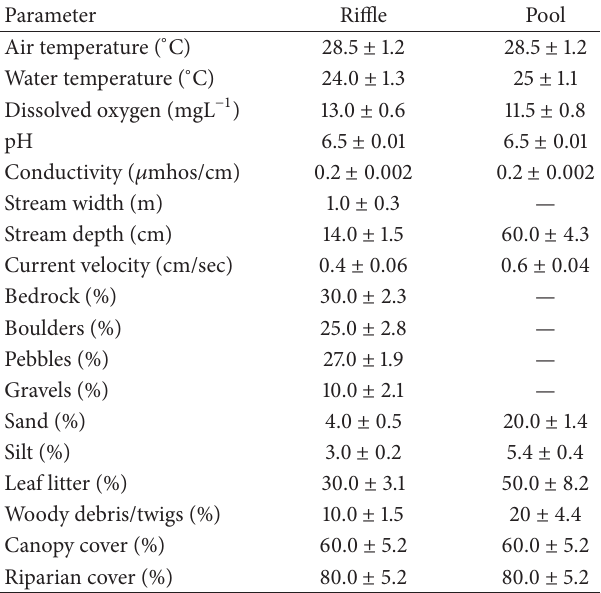
Table 1: The physicochemical parameters (mean ± SE) of a Thada- ganachiamman stream in the Sirumalai hills of Southern